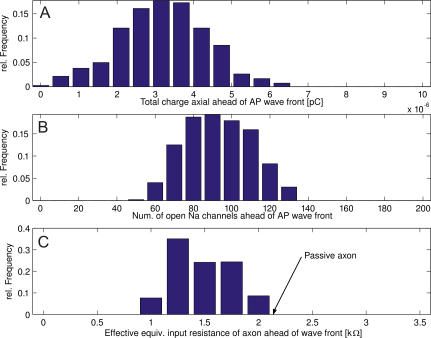
Variability Experienced by Propagating APs (Data for 0.3 μm Diameter Axon, N = 671)(A) Axial charge generated by incoming AP.(B) Number of open Na channels under the rising foot of the AP.(C) Input resistance of the resting axon as experienced by the incoming AP wavefront. Arrow indicates the axonal input resistance when all voltage gates are closed.